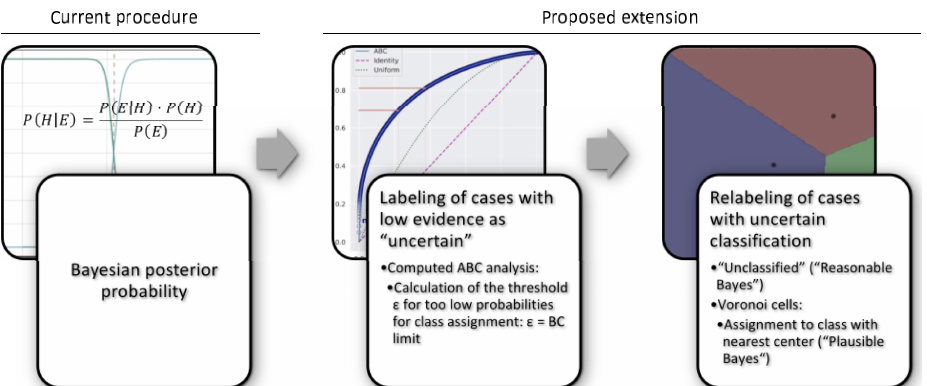
Figure 5. Proposed algorithm to circumvent misclassifications that occasionally occur when using the posterior probabilities in Bayes’ theorem that are very low. The threshold ε below which the evidence is considered as low is estimated for each pdf of the posteriors using a computed ABC analysis. Subset “C” of this item categorization contains the nonprofitable values, i.e., the lowest probabilities (“the trivial many”). These cases are classified as “uncertain”. Subsequently, a relabeling of these cases is performed, either as “unclassified”, which is referred to as “reasonable Bayes”, or they are assigned to the class with nearest class center based on Voronoi cell discrimination, which is referred to as “plausible Bayes”. Please note that the first row of panels shows schematic drawings similar to the main calculations in each step. The details are not explained. The second row of panels describes the individual steps. The figure was created using Microsoft PowerPoint (Redmond, WA, USA) on Microsoft Windows 11 running in a virtual machine powered by VirtualBox 6.1.36 (Oracle Corporation, Austin, TX, USA) as guest on Linux, and then further modified with the free vector graphics editor Inkscape (version 1.2 for Linux, https://inkscape.org/ (accessed on 18 September